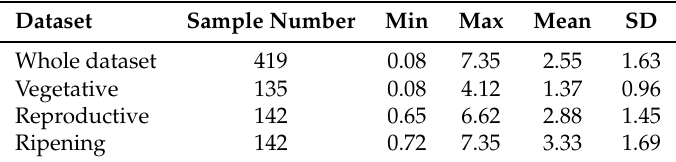
Table 3. Descriptive statistics of measured leaf area index (LAI) for each single growth stage and for the whole growing season.